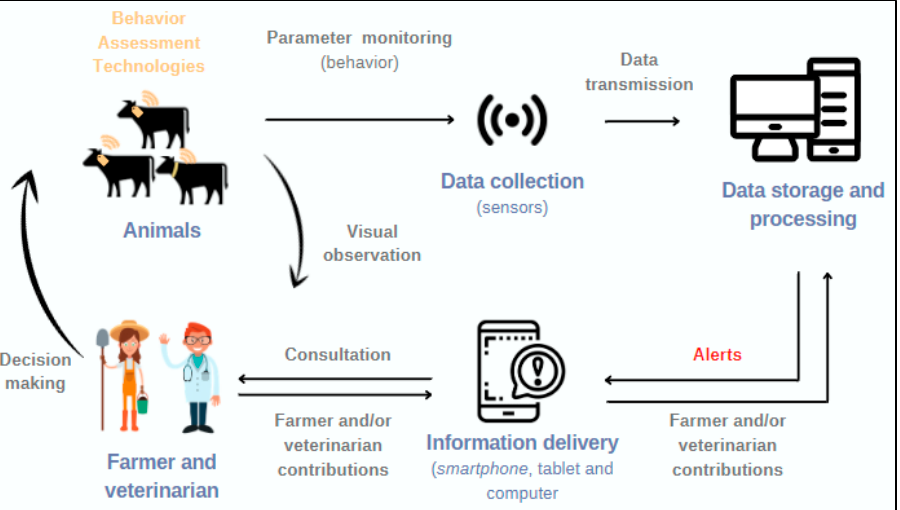
Figure 1. Diagram of health management at a cattle farm when implementing behavior assessment systems (BAS). Adapted from [25] but originally created by the authors.